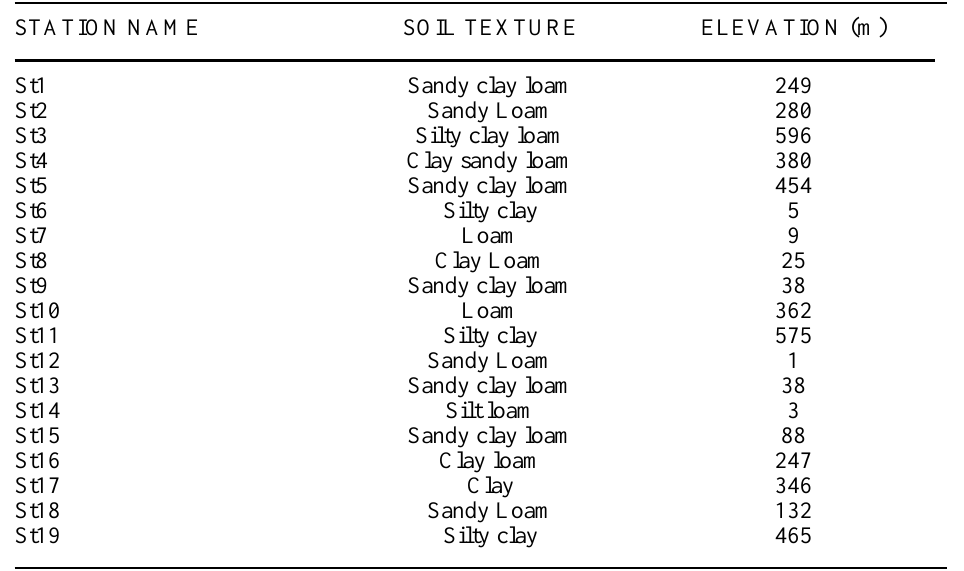
Table 1. Principal characteristics of weather stations used in the